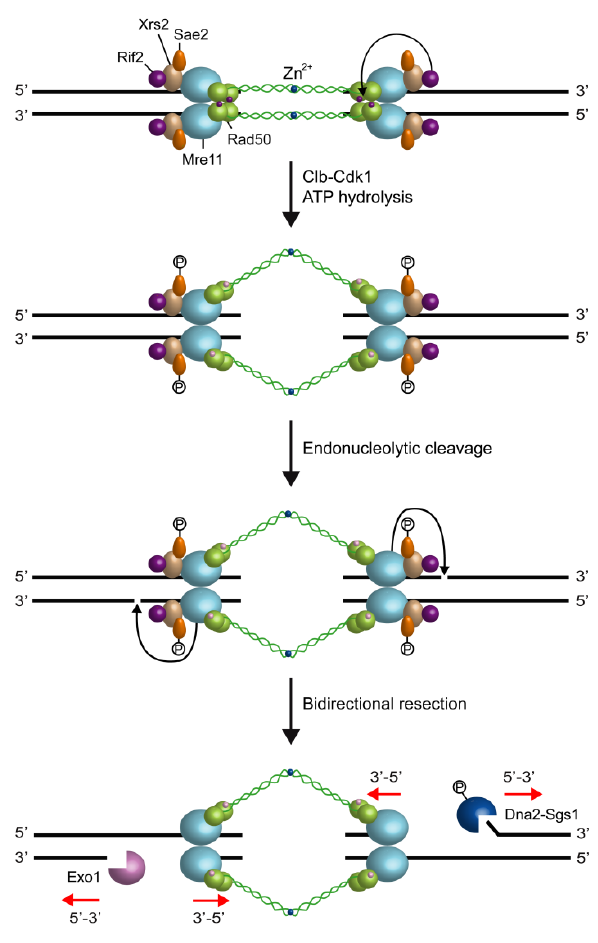
FIGURE 2: Model for DSB resection. The MRX complex and Sae2 are recruited to DNA ends. In the ATP-bound state, Rad50 blocks the Mre11 nuclease and MRX promotes DNA tethering. After ATP hydrolysis by Rad50, the Mre11 nuclease sites are exposed and can catalyze an endonucleolytic cleavage of the 5’ strand. Rif2 can promote the ATP hydrolysis activity of Rad50. MRX-mediated incision requires Sae2 phosphorylation by Cdk1-Clb and allows bidirectional processing by Exo1 and Sgs1-Dna2 in the 5’-3’ direc- tion from the nick and by MRX in the 3’ to 5’ direction toward the DSB ends. ATP and ADP are indicated by purple and pink dots,